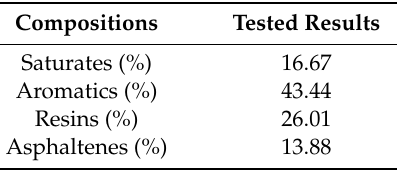
Table 2. Compositions of base asphalt.